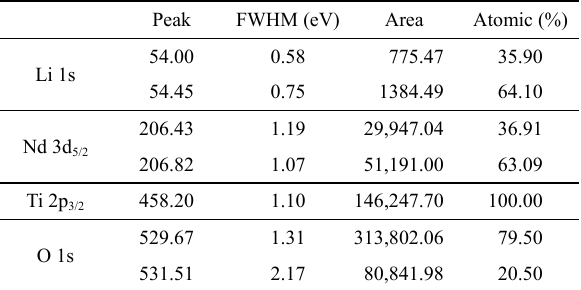
Fig. 7 (a) Survey spectrum of LZTNN0.2 ceramics and high-resolution XPS spectra of (b) Li 1s, (c) Zn 2p, (d) Ni 2p, (e) Nd 3d, (f) Ti 2p, and (g) O 1s. Table 3 Convoluted peaks of Li 1s, Nd 3d, Ti 2p, and O